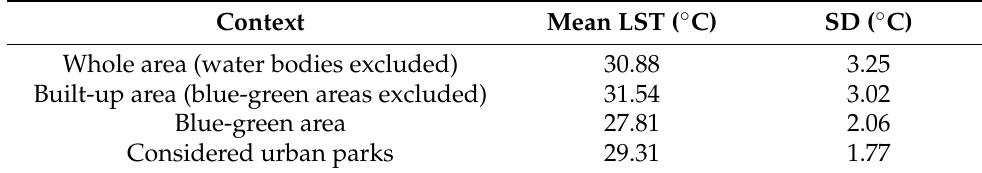
Figure 2. Spatial distribution of LST (land surface temperature, ◦ C) (water bodies outside eliminated). Table 1. Statistics of mean LST (land surface temperature) and SD (standard deviation)